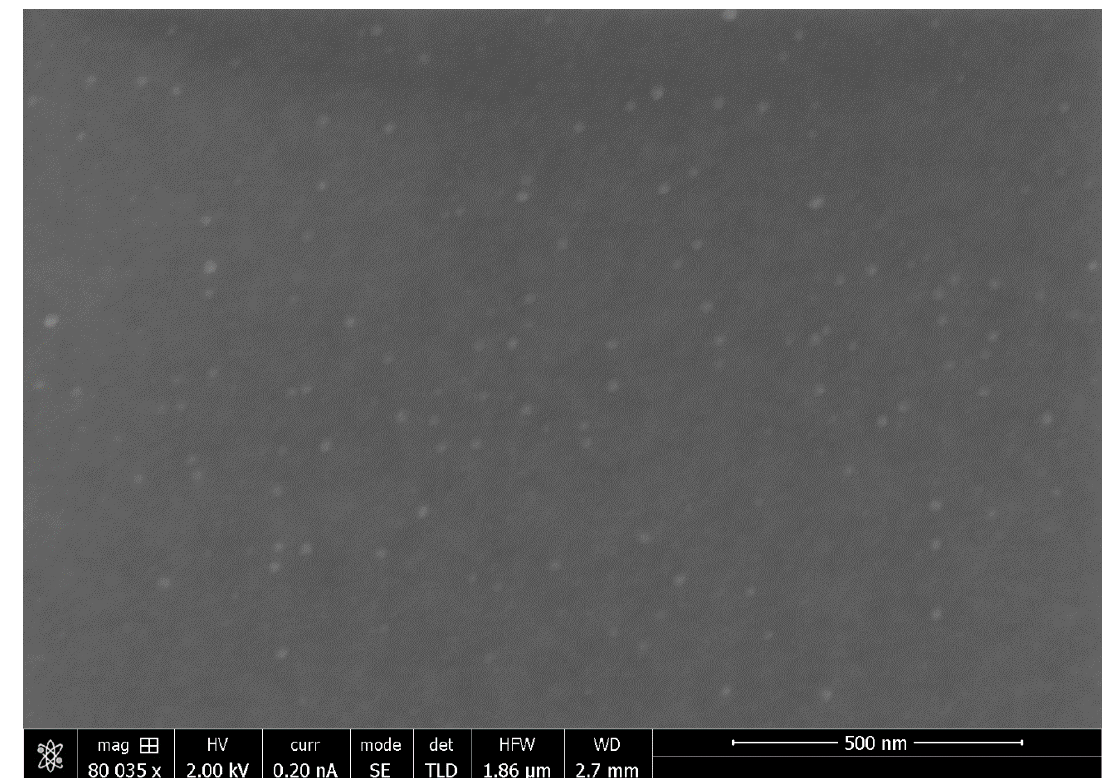
Figure 10. SEM image of a silver-loaded PVA film containing 3% w/w silver nitrate that had been heat cured for 90 min at 140 °C.